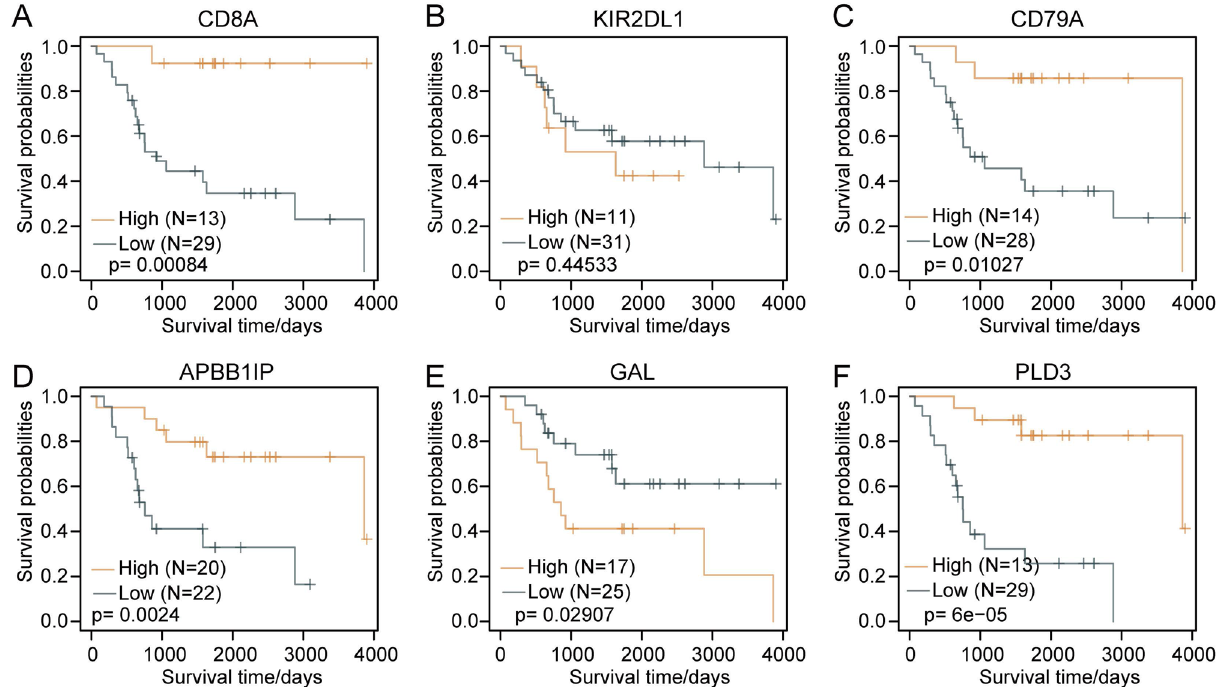
Figure 4. Kaplan–Meier curves for the 6 genes (in the TARGET training cohort). ( A ) Kaplan–Meier curve for the CD8A gene. ( B ) Kaplan–Meier curve for the KIR2DL1 gene. ( C ) Kaplan–Meier curve for the CD79A